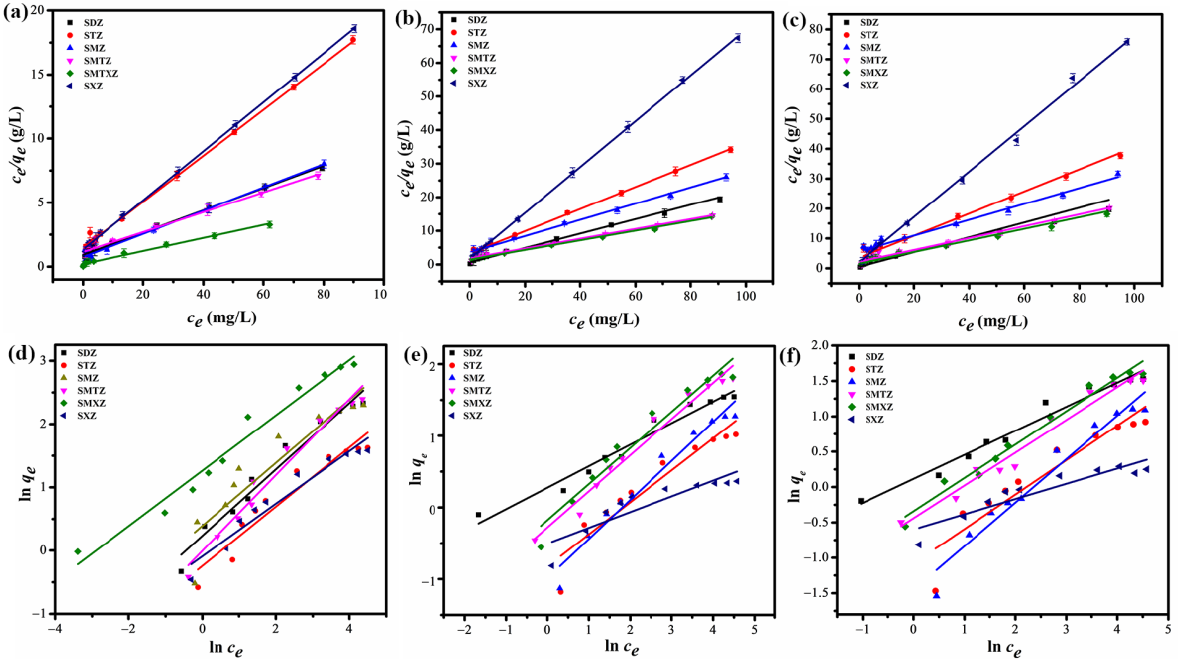
Figure 5. ( a ) Langmuir fitting curves, ( a ) BiFeO 3 /MXene, ( b ) MXene, and ( c ) BiFeO 3 . Freundlich fitting curves ( d ) BiFeO 3 /MXene, ( e ) MXene, and ( f ) BiFeO 3 for sulfonamides adsorption in a mixed system at pH 6. Table 2. Fitted parameters of Langmuir model and Freundlich model for the adsorption of sulfonamides. Langmuir Model Freundlich